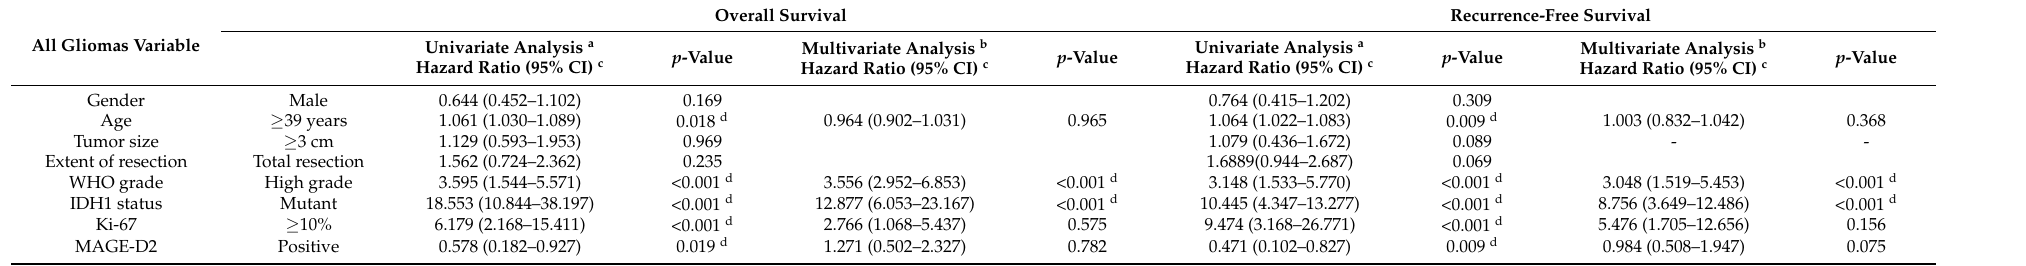
Table 4. Univariate and Multivariate analysis of different prognostic